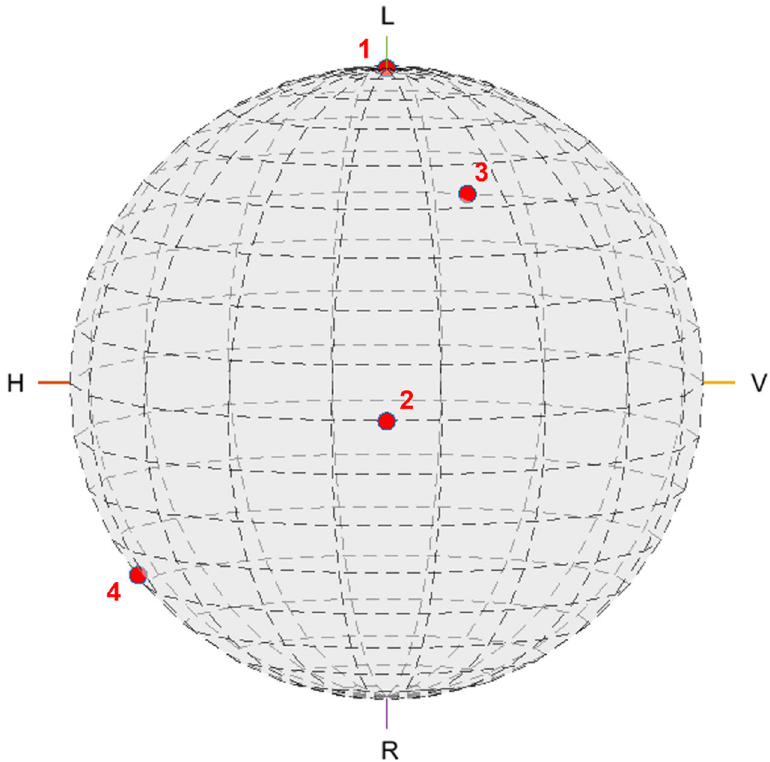
Figure 5. Illustrating the Poincar é Sphere. Pure left-hand circular polarization is at the ‘North Pole’ and pure right-hand circular polarization is at the ‘South Pole’. Linear polarization is plotted at the ‘Equator’, with (in this orientation) pure horizontal ( τ = 0°) to the left and pure vertical ( τ = ±90°) to the right. Note that, in this view, negative tilt angles would appear on the rear surface of the sphere. Example polarization state mappings are marked with red dots (1: LH circular; 2: Linear, tilt angle +45°; 3: LH elliptical, tilt angle +55°/axial ratio − 2.5; 4: RH elliptical, tilt angle + 7°/axial ratio + 3).